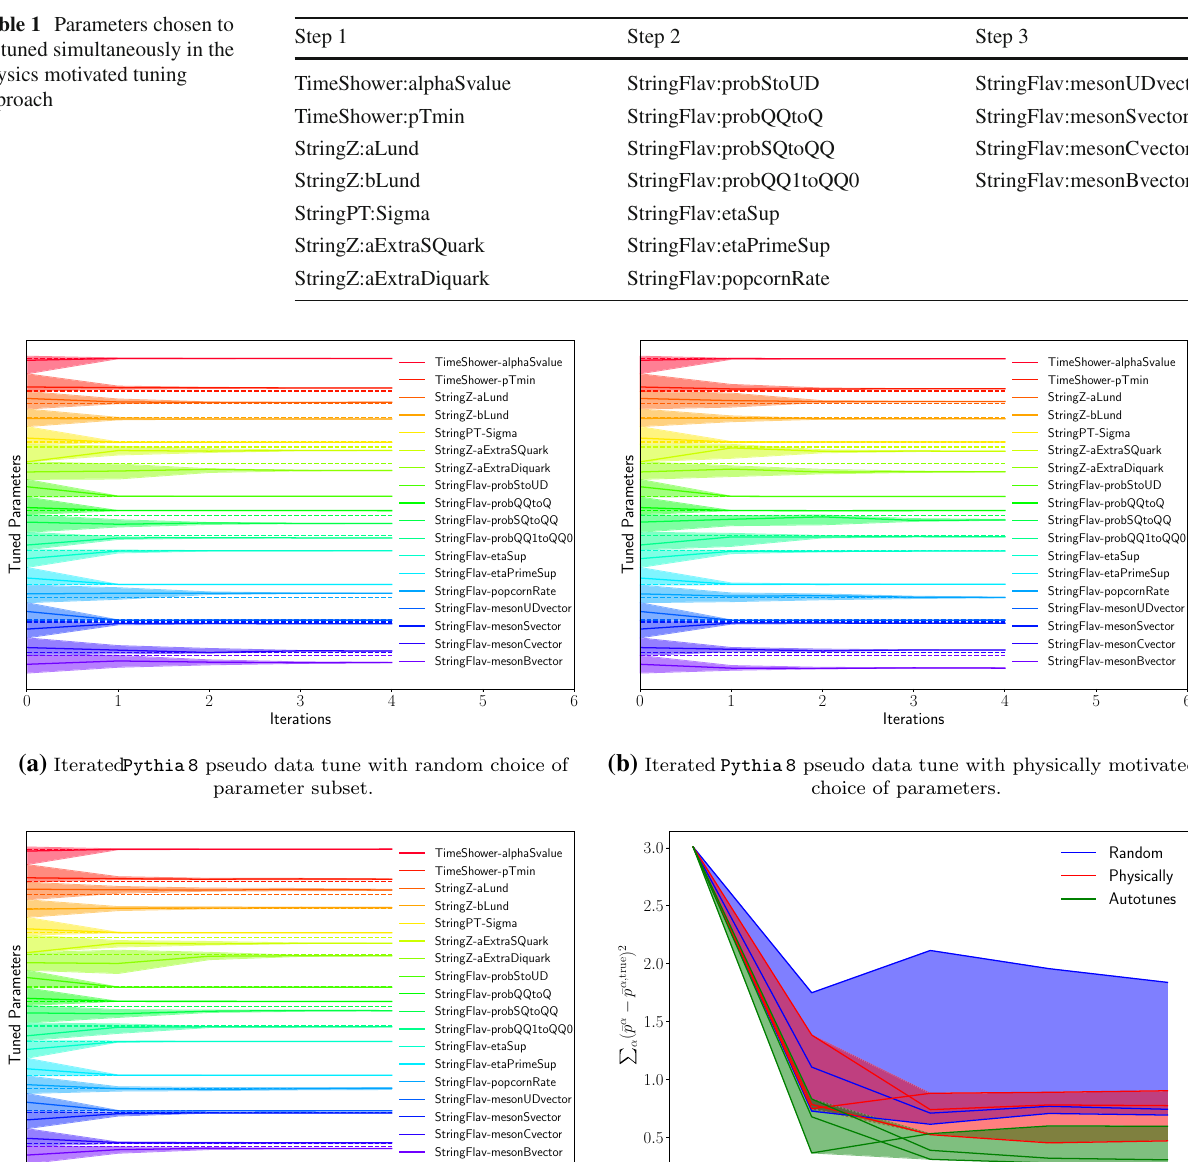
Fig. 5 Parameter development as a function of tune iterations. Each iteration consists of a full tuning procedure with three sub-tunes, using the optimized parameter values and ranges of the preceding iteration as starting conditions. The dashed lines in Fig. 5a–c show the true param- eter point that was used to produce the pseudo data. The uncertainty